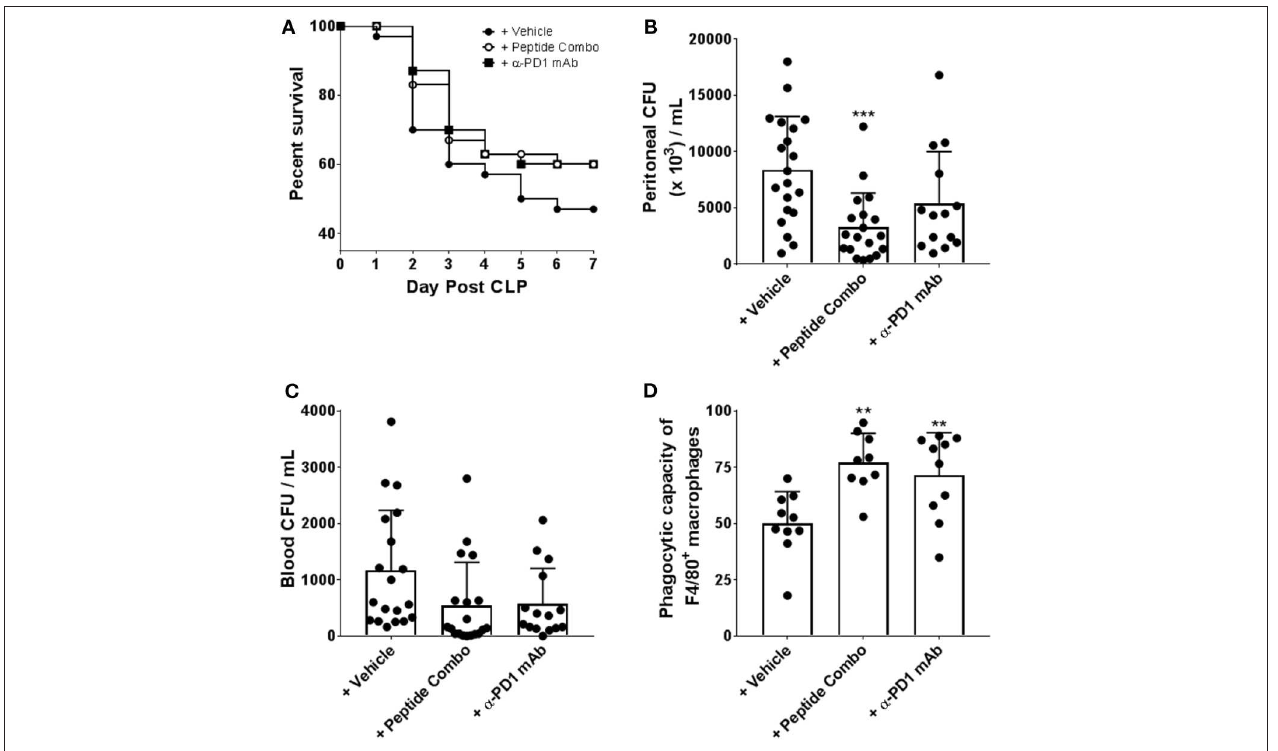
FIGURE 6 | Enhanced survival, bacterial clearance and macrophage function in CLP induced septic mice following treatment with PD1 peptide antagonists. (A) PD1 peptide antagonist treatment enhances survival of CLP-induced sepsis in mice. Mice were subjected to CLP and treated with vehicle ( n = 30), PD1 peptide antagonists ( n = 30) or α -PD-1 mAb ( n = 30) and survival was monitored for 7 days. The vehicle is a 0.1M sodium acetate solution. Data were pooled from six independent experiments. (B,C) PD1 peptide antagonists treated mice had reduced bacterial burden after CLP. Bacteria levels were expressed as CFU per 1mL. Data were pooled from five to seven independent studies ( n = 20). Data are expressed as the mean ± SD. (D) Septic peritoneal macrophages from each group were fed fluorescently-conjugated E. coli and quantitative analysis of phagocytosis was measured by flow cytometry. Macrophages were identified as F4/80 + . Data were pooled from four independent studies ( n = 9–10). Data are expressed as the mean ± SD. Significant differences between saline and treated mice were determined using a one-way ANOVA multiple comparisons test, and are denoted by ** p < 0.01 and *** p <